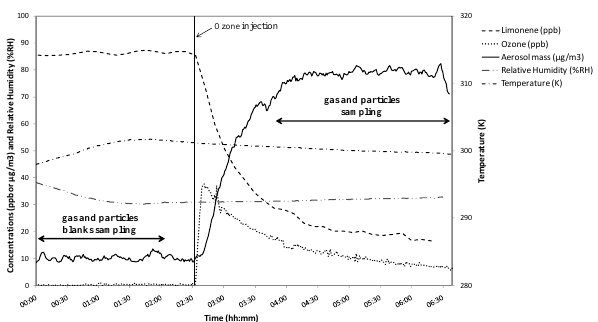
1 2 Fig. 13. Evolution of limonene ozonolysis experiment parameters. Fig. 13. Evolution of limonene ozonolysis experiment